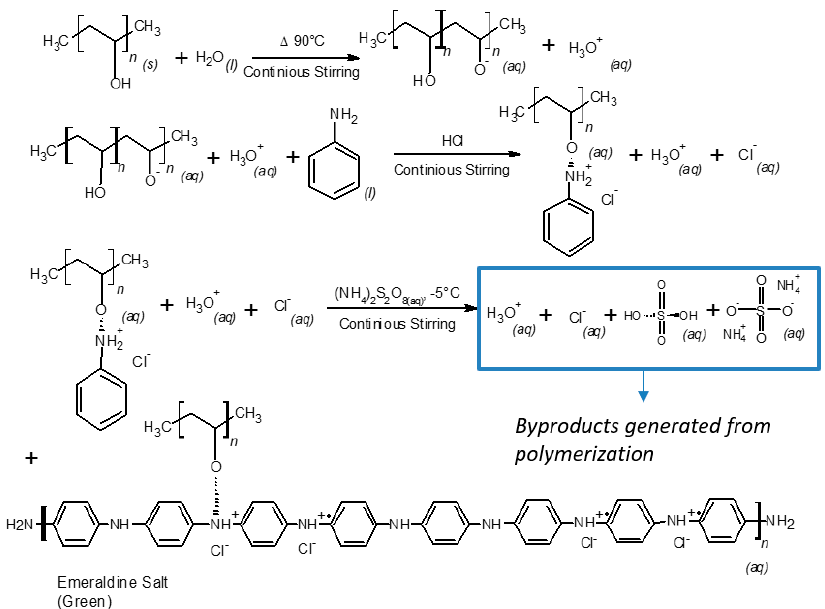
Figure 8. Synthesis route of PVA–PANI and generated byproducts.